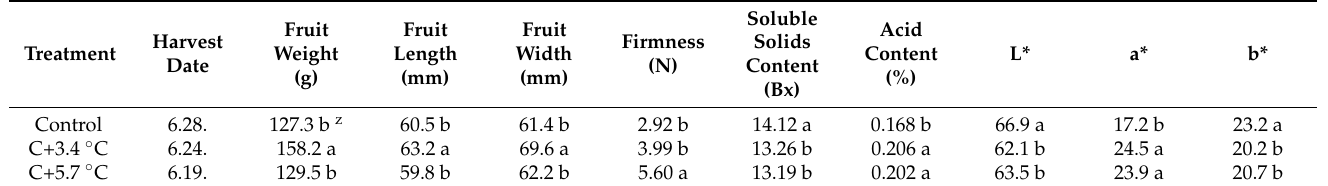
Table 2. Harvest dates and the fruit quality of ‘Mihong’ peaches affected by elevated temperature under a carbon dioxide concentration of 700 µ mol · mol − 1 .